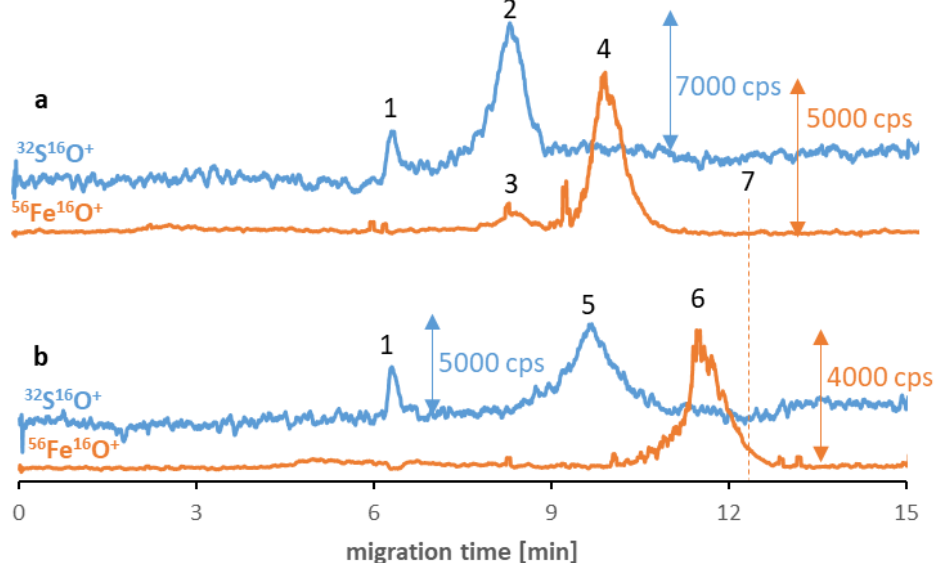
Figure 2. CE-ICP-MS/MS electropherograms’ MS/MS signals 32 S 16 O + and 56 Fe 16 O + of a mixture of Fe 3 O 4 @Citr (10–20 µg Fe/mL) and transferrin ( a ) and albumin ( b ), 1 mg/mL each, diluted in 10 mM phosphate buffer, pH 7.4, and 100 mM NaCl, and incubated at 37 °C for 6 h. Signal assignment: blank sulfur signal (1), transferrin (2), Fe from the transferrin (3), Fe 3 O 4 @Citr (4 and 6), albumin (5), Fe 3 O 4 @Citr analyzed individually (7); separation under optimized conditions (see Tables 1 and 2).